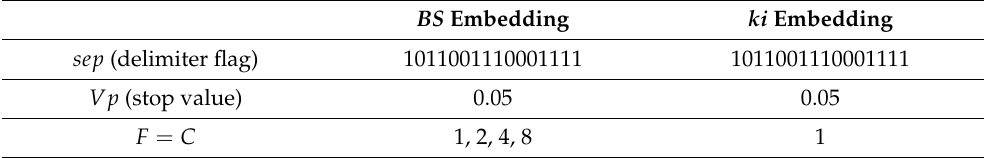
Table 2. Summary of recommended